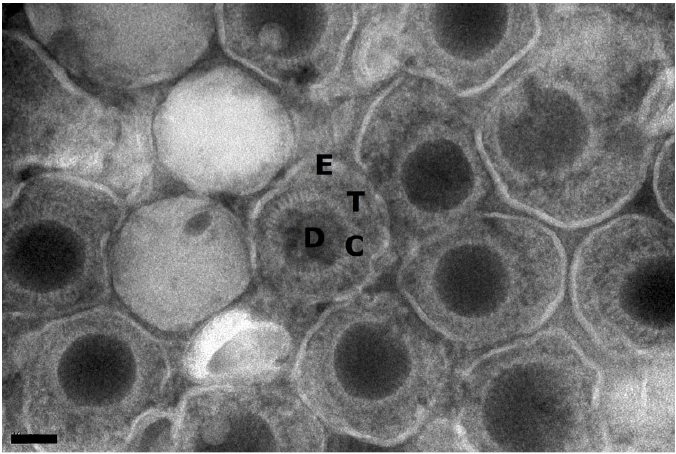
Figure 1. Transmission electron micrograph of a negatively stained preparation of purified extracellular HCMV (Towne) virions. The virion in the center is labeled for the genomic DNA (D), Capsid (C), Tegument (T), and envelope (E) layers. The dense bodies, composed of tegument proteins but no nucleocapsid, can be seen to the left of the labeled virion. Scale 40